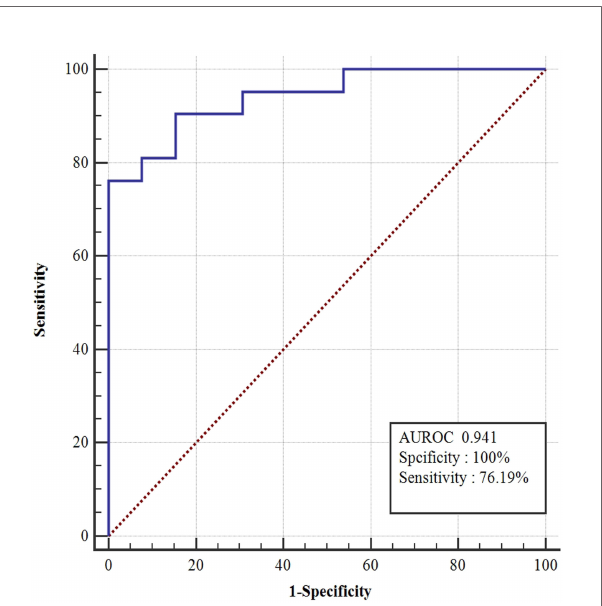
FIGURE 6 | ROC curves of model (y=33.933-0.001*BaselinelgG1- 0.002*BaselinelgG2). According to the univariate regression analysis, strong predictors included: baseline lgG1, lgG2, lgG3, and lgG4 levels; week 12 IgG1, lgG2, lgG3, and lgG4 levels; and week 24 IgG1, lgG2, lgG3, and lgG4 levels; HBsAg at 12 and 24 weeks; HBsAg change form baseline at 12 and 24 weeks. A multi-factor logistic analysis was performed with y=33.933- 0.001*BaselinelgG1-0.002*BaselinelgG2. The area under the curve was up to 0.941 with 100% sensitivity and